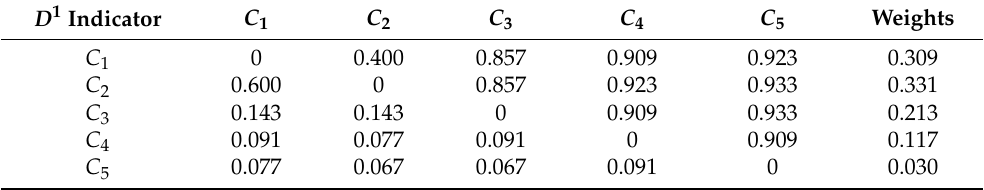
of expert D 1 for the first-level indicators. 1